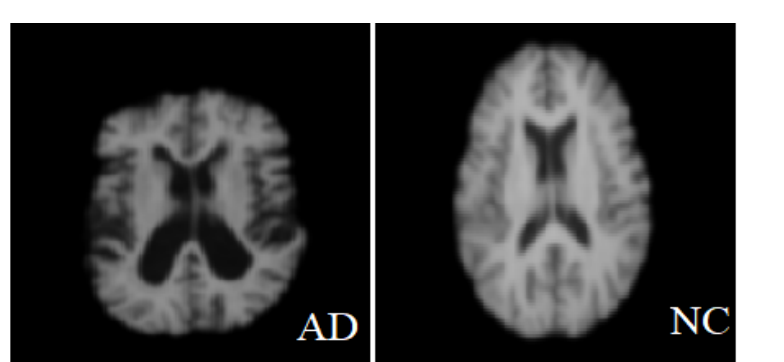
Figure 3. MRI Imaging Planes.